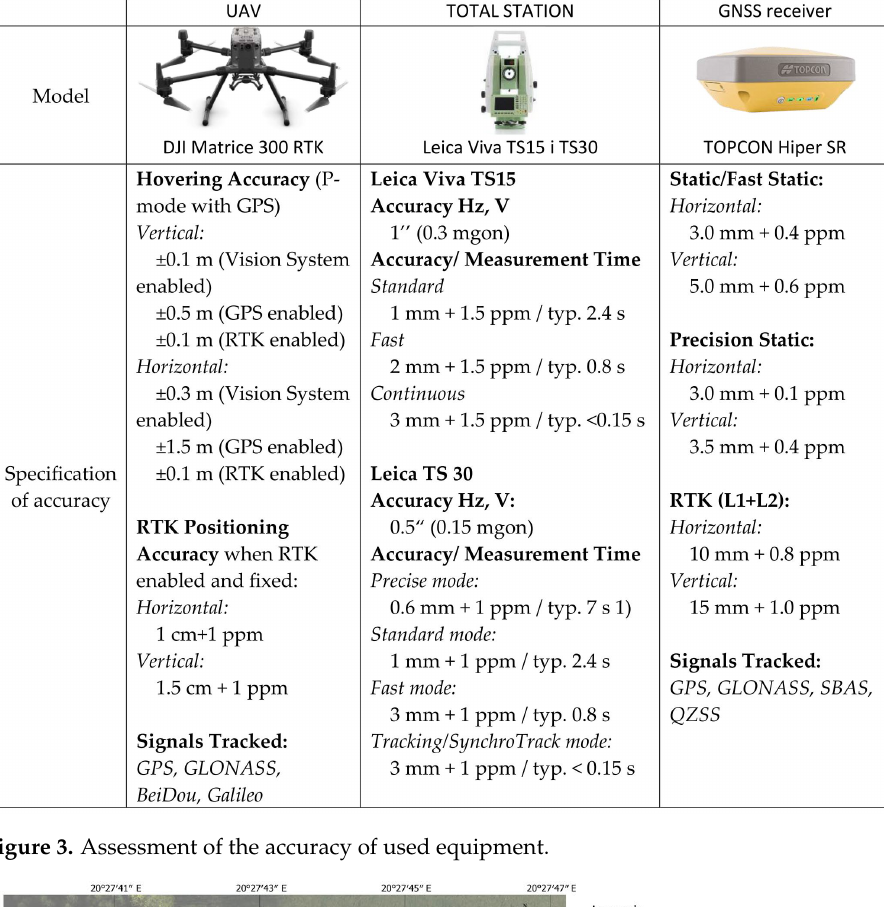
Figure 3. Assessment of the accuracy of used equipment.